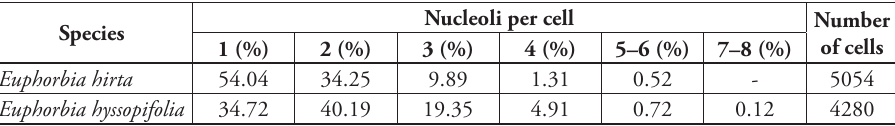
Table 1. Nucleolar frequency by interphase nucleus in mitotic cells of Euphorbia hirta and E. hyssopifolia . Nucleoli per Species